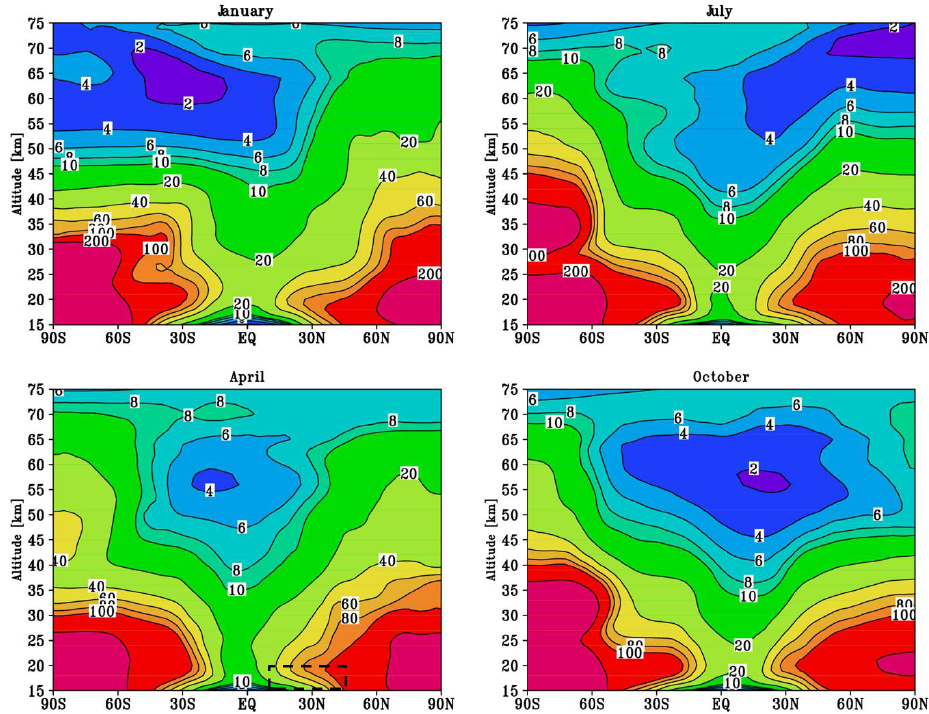
Fig. 5. Volumetric mass of MSP Fe ( × 10 − 17 gcm − 3 ) calculated from the monthly mean MSP number densities from 2000–2005, predicted by UMSLIMCAT (global meteoric mass input rate=22td − 1 ). The dashed outlined box in the plot for April indicates altitude and latitude ranges relevant to the measurements of Fe content in SSA (see text).